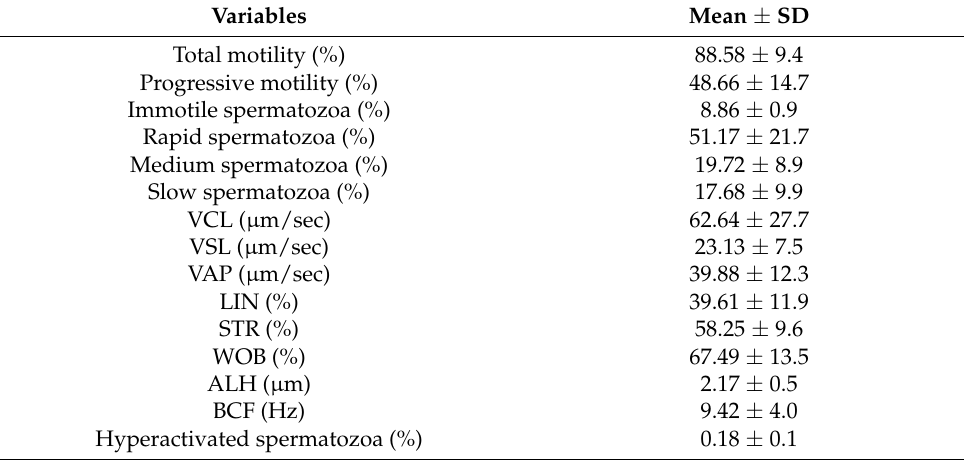
Table 2. Sperm kinetic parameters after CASA analysis of boar semen samples (n = 65).